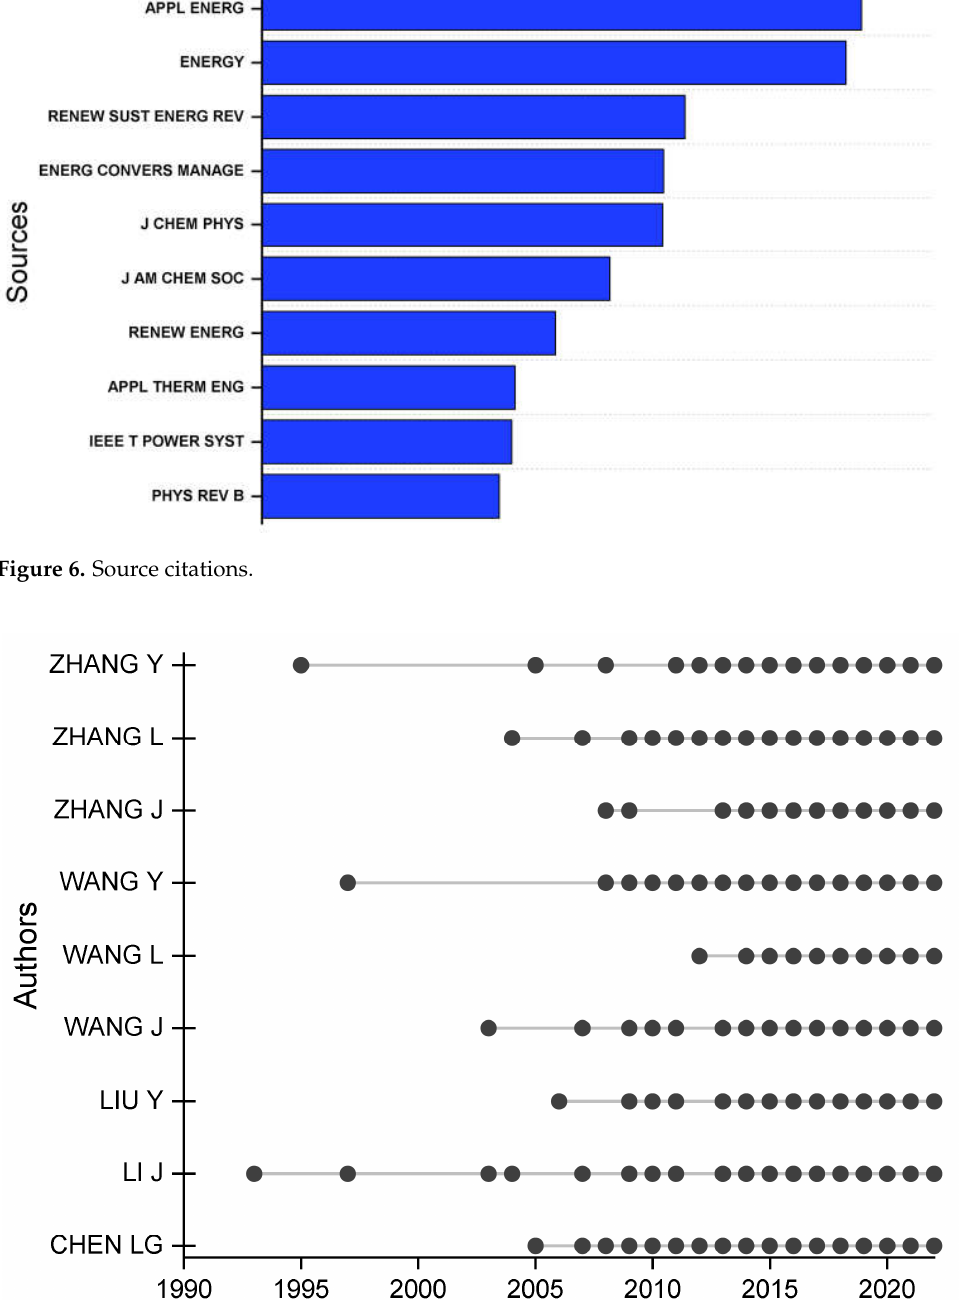
Table 3. H-Index top ten authors.